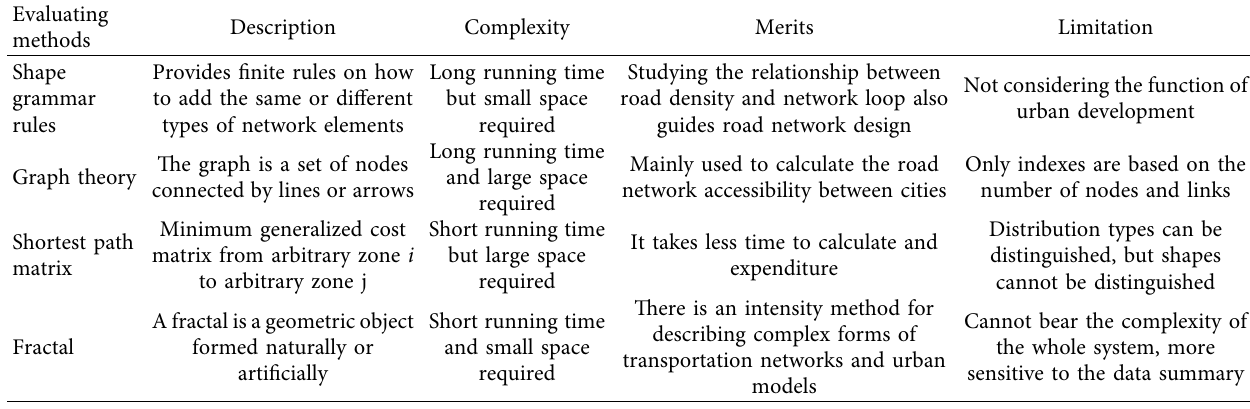
Table 2: Merits and limitations of existing road network evaluation methods.